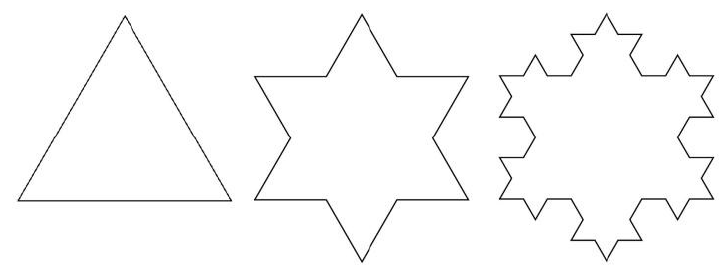
Figure 1. Ω n α , with α = 3 and n = 0 (the initial polygon), n = 1, n =